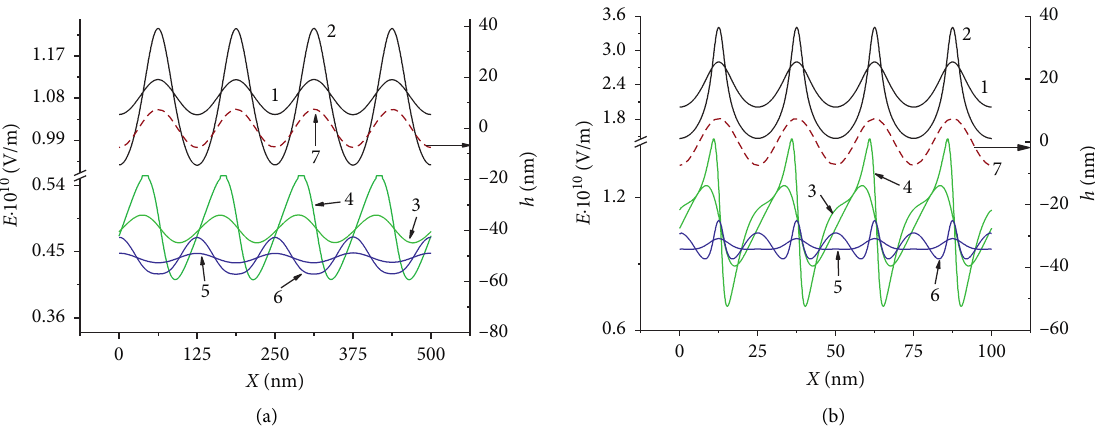
Figure 2: Distributions of the modulus of the electric field along the “quartz-chlorine gas” interface, which has a sinusoidal profile with � 0 . 8 · 10 − 2 nm − 1 (a) and ] � 4 · 10 − 2 nm − 1 (b) at different angles of the incident wave: θ spatial frequencies ] 1 2 responds to h � 4 nm and curve 2 corresponds to h � 16nm); θ in � 30 ° (curve 3 corresponds to h � 4 nm and curve 4 corresponds to � 80 ° (curve 5 corresponds to h � 4nm and curve 6 corresponds to h � 16 nm). The wavelength of the incident radiation h � 16nm), θ in (in vacuum) is λ � 500nm. The protrusion height of the sinusoidal profile is h � 16nm (curve 7).